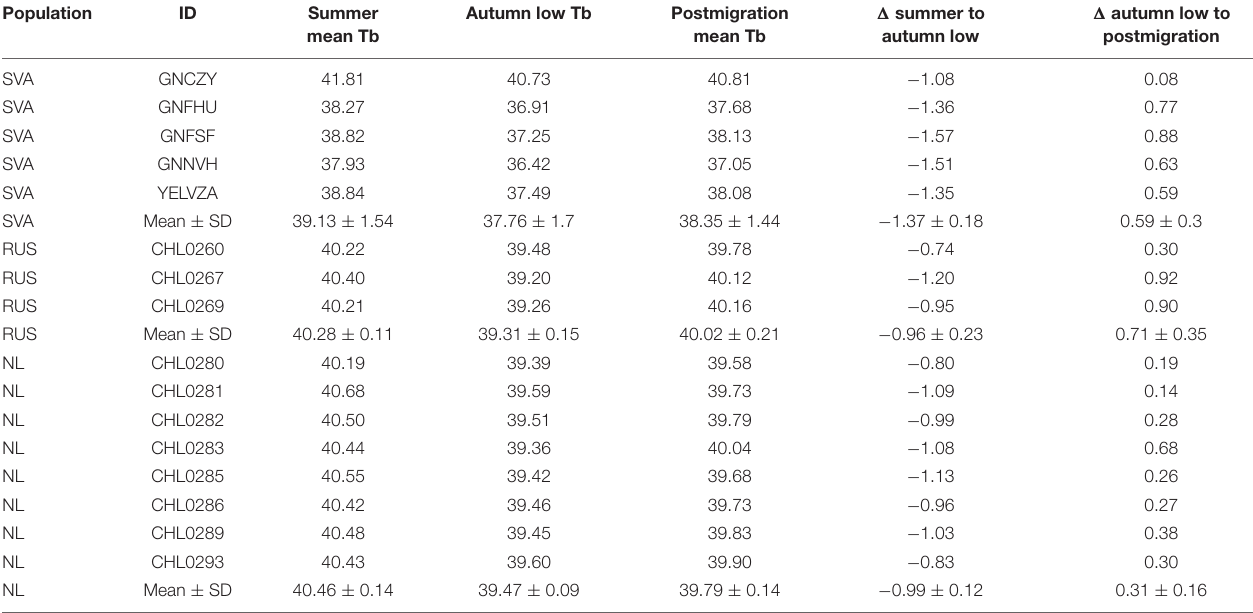
TABLE 1 | Daily mean body temperature (Tb, in ◦ C) in individual barnacle geese from Arctic-migratory populations in Svalbard (SVA) and Russia (RUS), and from a non-migratory population in Netherlands (NL) at three time periods / states around autumn migration. Population ID Summer Autumn low mean Tb